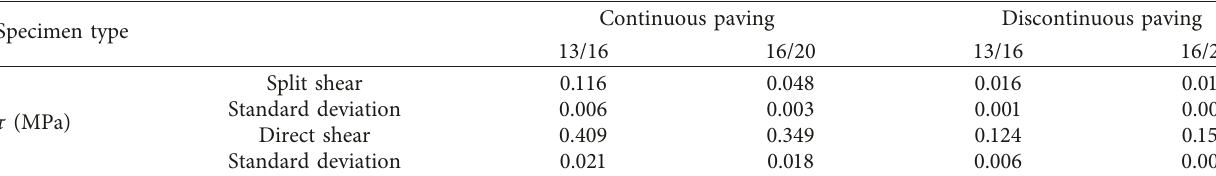
Table 7: Results of shear test at freeze-thaw condition.